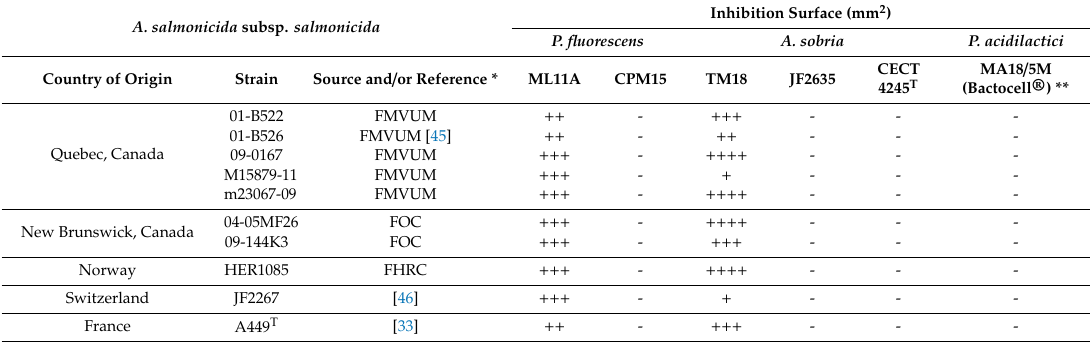
Table 2. Di ff usible inhibitory e ff ect of brook charr probionts on Tryptic Soy Agar (TSA) bacterial lawns of A. salmonicida subsp. salmonicida , after 96 h at 18 ◦ C.